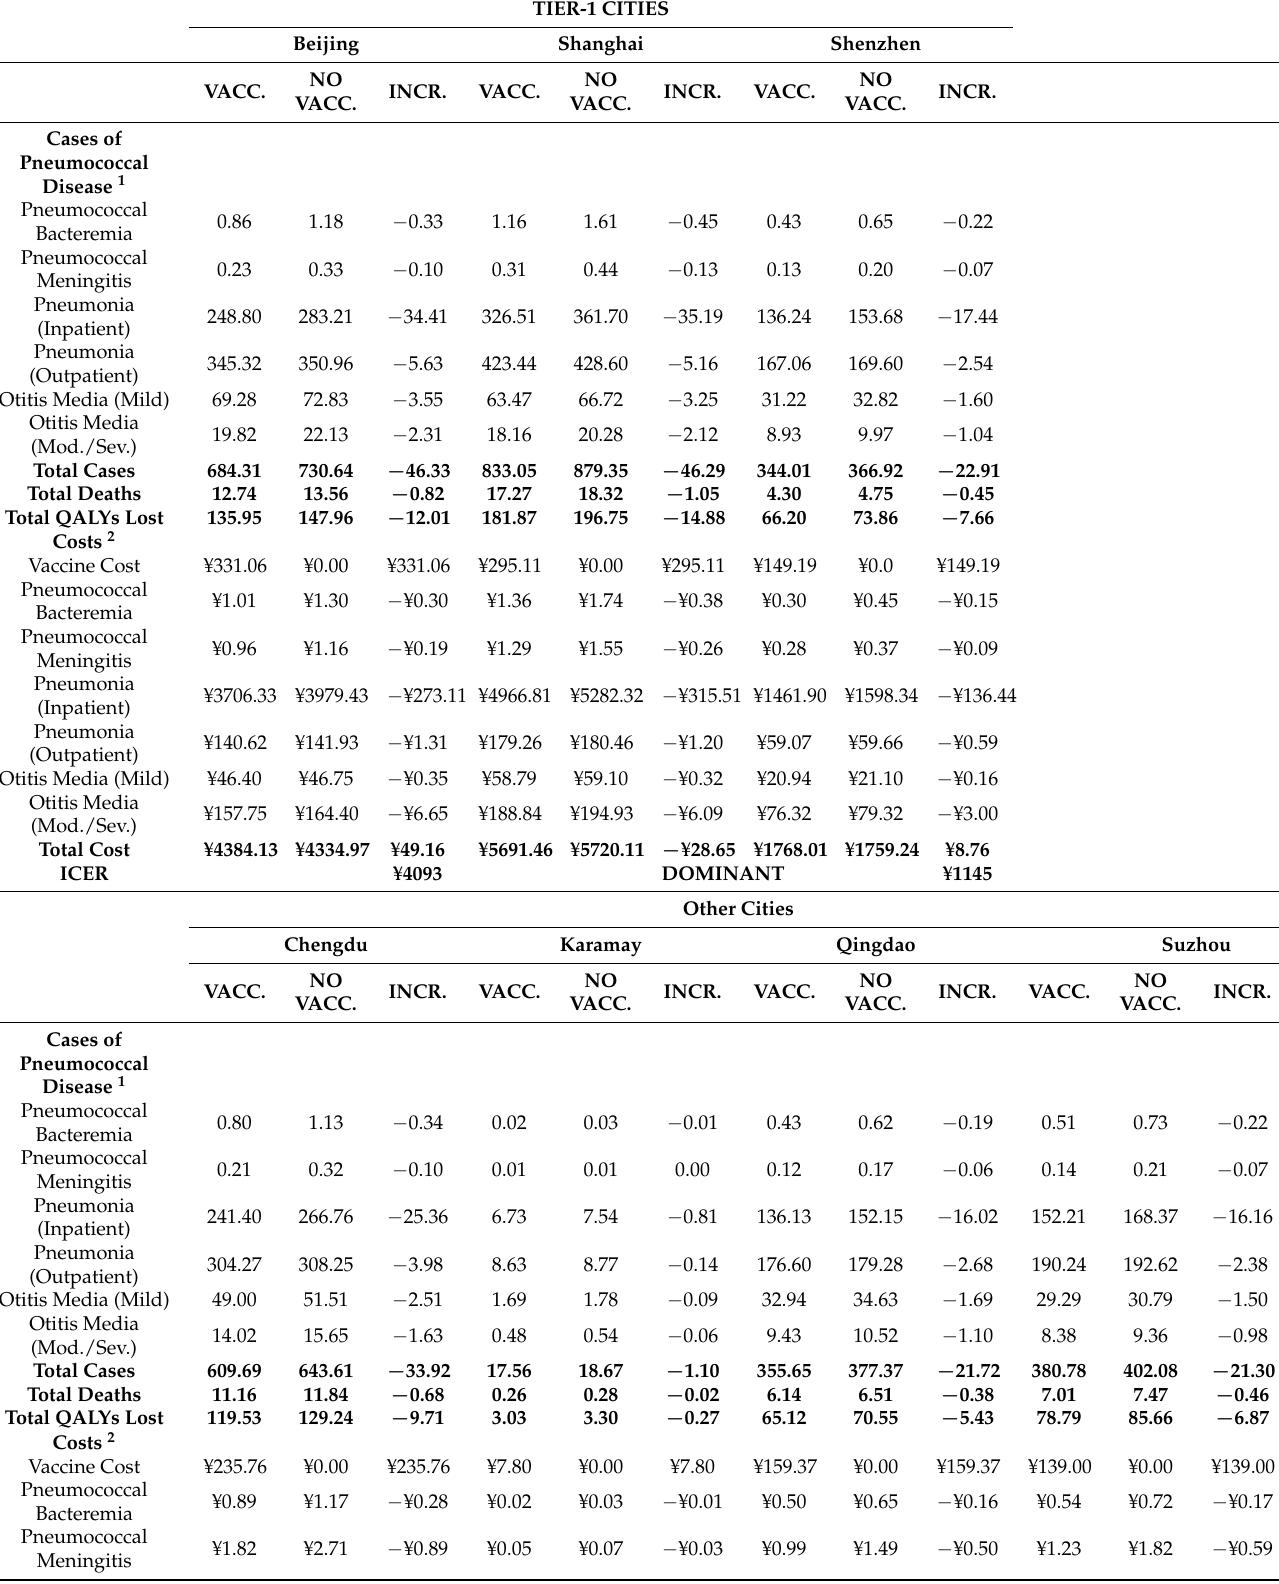
Table 3. Base Case Results—Total Cases and Costs with and without the PCV13